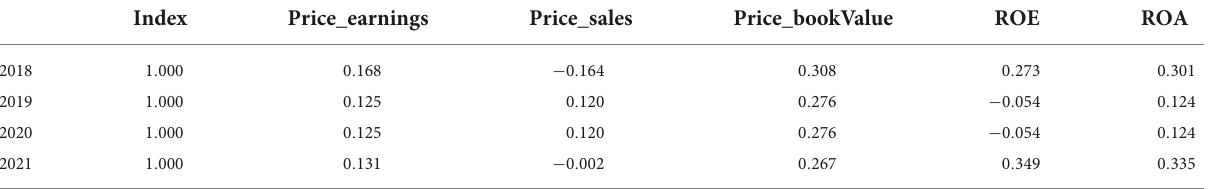
TABLE 7 Correlations (AeRO